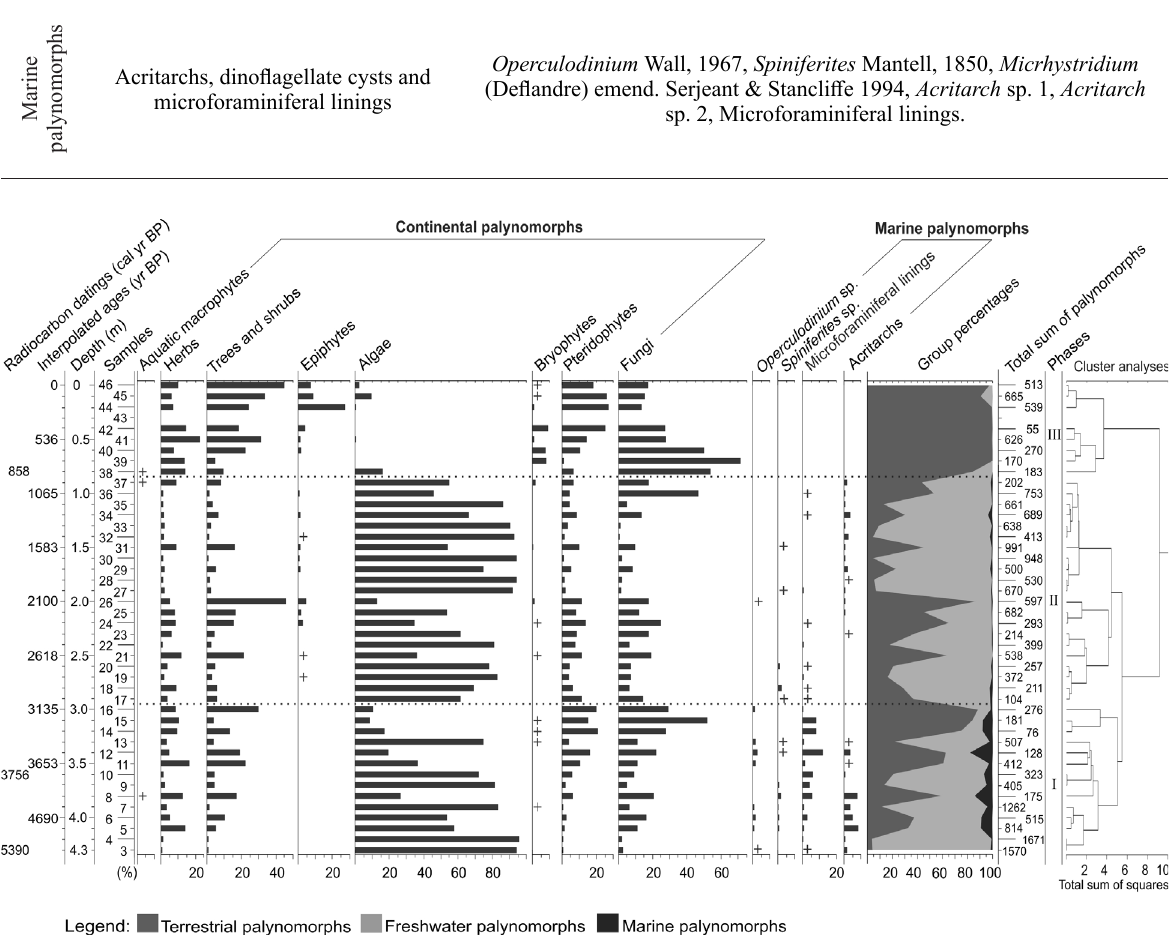
Figure 3 - Percentage diagram of the palynomorphs grouped according to their ecological affinities (habit or habitat) from the PCSC-3 core, as well as the identified phases and cluster analyses. The symbol (+) represents an occurrence of palynomorphs. SYSTEMATIC